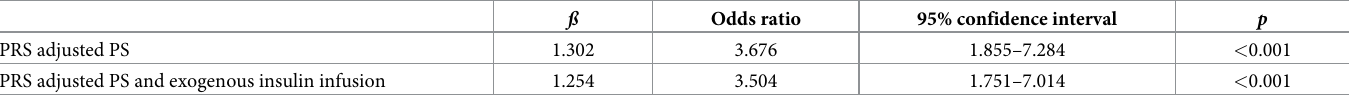
Table 3. Association of PRS with occurrence of hyperglycemia ( > 200 mg/dL) at the neohepatic phase in PS-matched